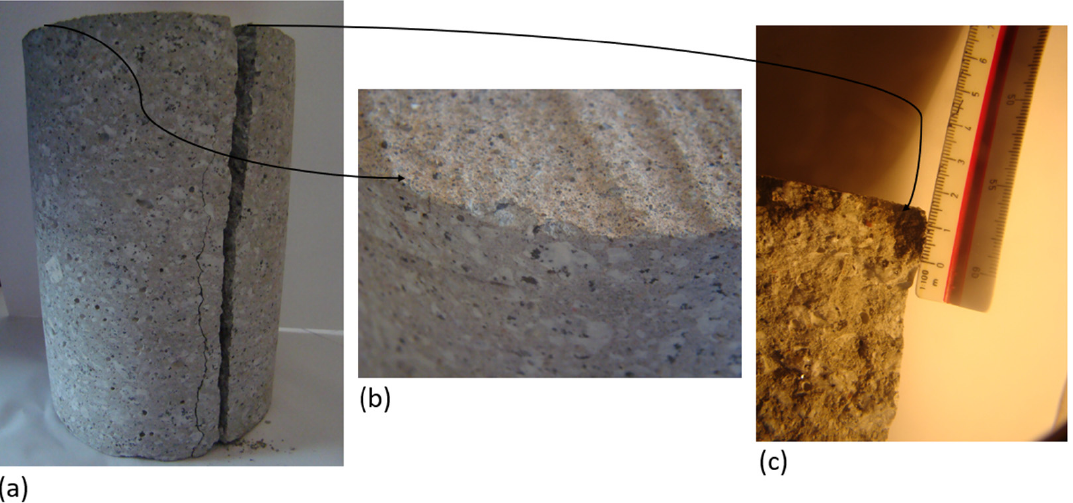
Figure 2. A test core taken from the used concrete airport pavement: ( a ) test core, ( b ) surface layer of the sample, and ( c ) cross-section of subsurface layer (sample diameter: 150 mm, sample height: 300 mm).